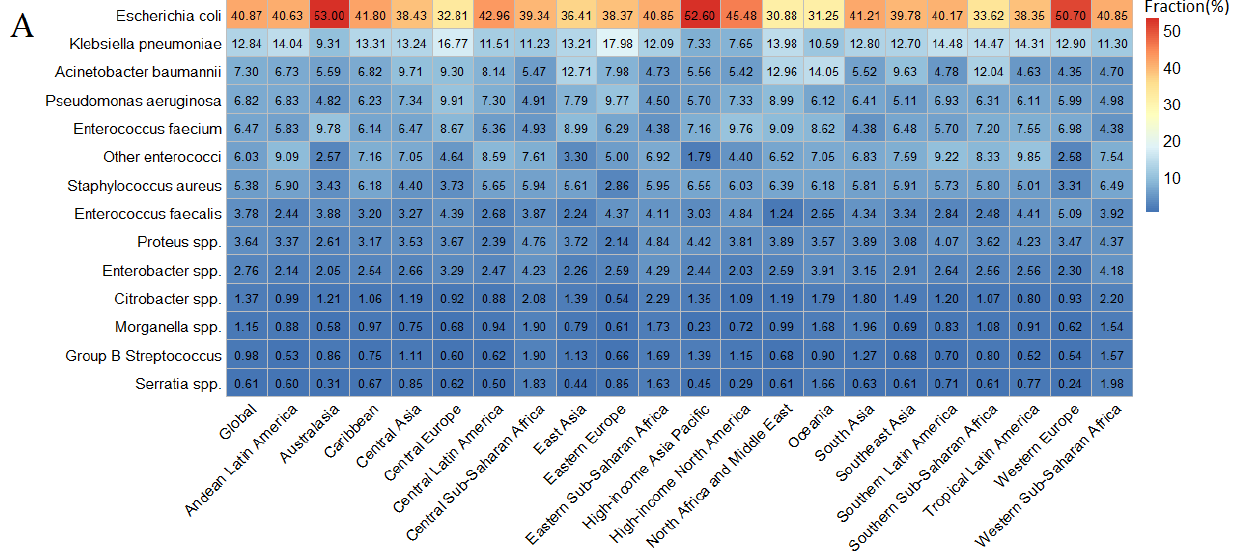
Figure 2. Fraction of deaths attributable to ( A ) and associated with ( B ) bacterial AMR among 21 GBD regions and 14 pathogens, 2019. AMR = antimicrobial resistance. GBD = Global Burden of Dis- eases, Injuries, and Risk Factors Study. 3.3. Antibiotic-Specific Burden of Bacterial AMR in UTI Globally, four antibiotic classes were each responsible for more than 100 thousand deaths associated with AMR: fluoroquinolones (169.15 thousand [95% UI: 119.64–240.75]), third-generation cephalosporins (113.06 thousand [95% UI: 78.60–163.97]), aminopenicil- lin (107.72 thousand [95% UI: 84.82– 139.29]), and β - lactam or β -lactamase inhibitors (104.54 thousand [95% UI: 76.74–144.36]). For deaths attributed to AMR, fluoroquinolones (21.12 thousand [95% UI: 14.14–31.53]) were still responsible for the most deaths in 2019, followed by carbapenems (21.12 thousand [95% UI: 14.14–31.53]) and third-generation cephalosporins (10.98 thousand [95% UI: 6.15–18.12]) (Figure 1C). The DALYs caused by 13 antibiotic classes were shown in Figure S4. Globally and in almost all 21 GBD regions, fluoroquinolones, carbapenems, and third-generation cephalosporins were the top three leading antibiotics attributed to AMR (Figure 3), but there were also a few exceptions. For instance, in Australasia, the second- ranked antibiotic class was β - lactam or β -lactamase inhibitors. For deaths associated with